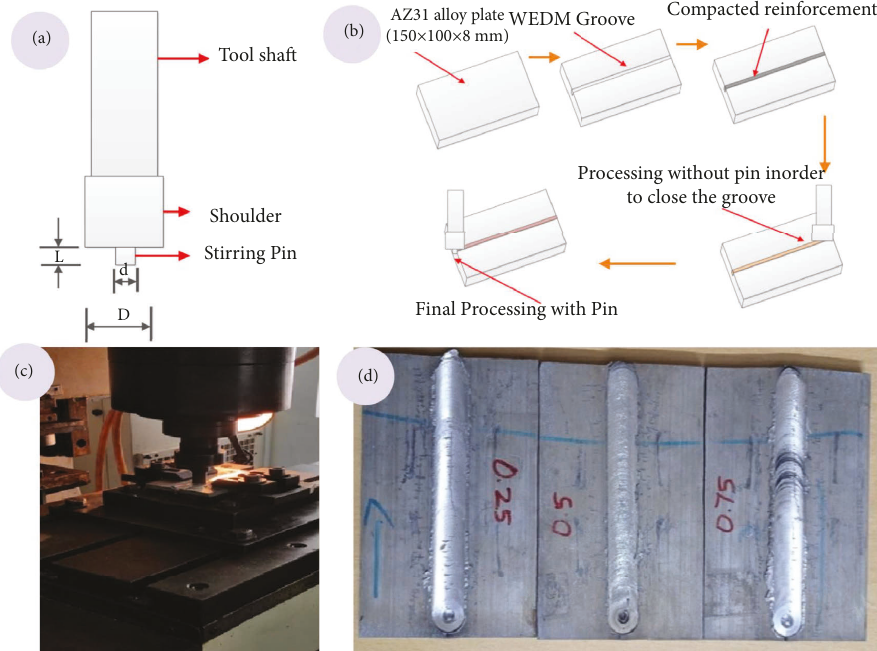
Figure 1: (a) Dimension of tool profile. (b) Schematic sketch of FSP. (c) Modified milling machine for the FSP approach. (d) Developed surface composite.